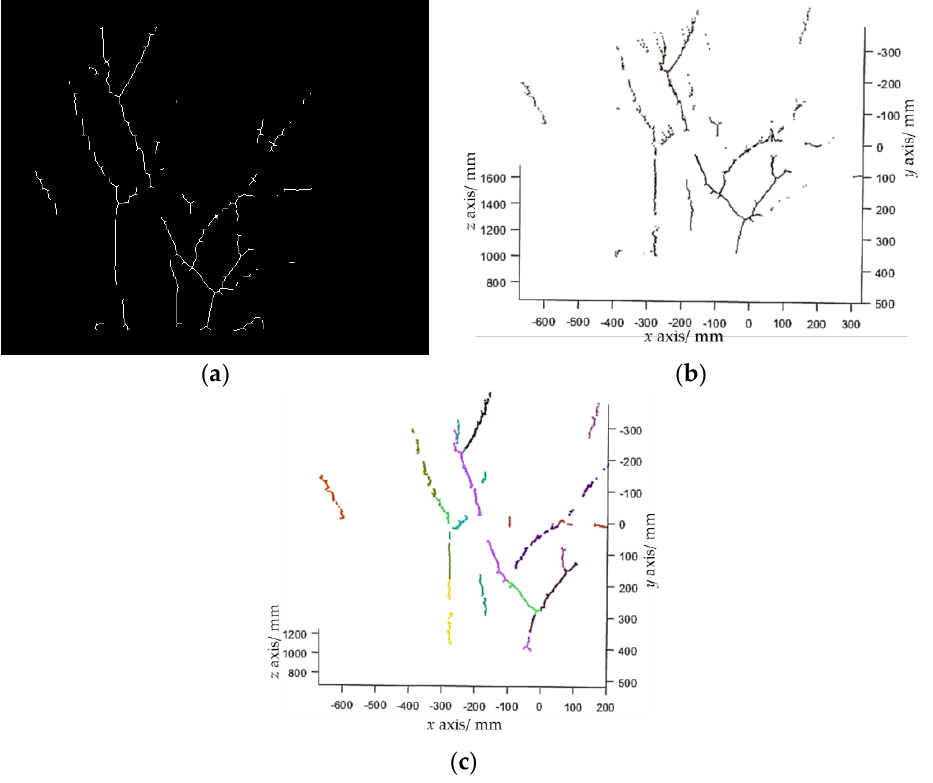
Figure 6. Branch reconstruction process. ( a ) Branch skeletons extracted from Figure 4b; ( b ) branch point cloud; ( c ) detected line segments, where each segment is marked with a random